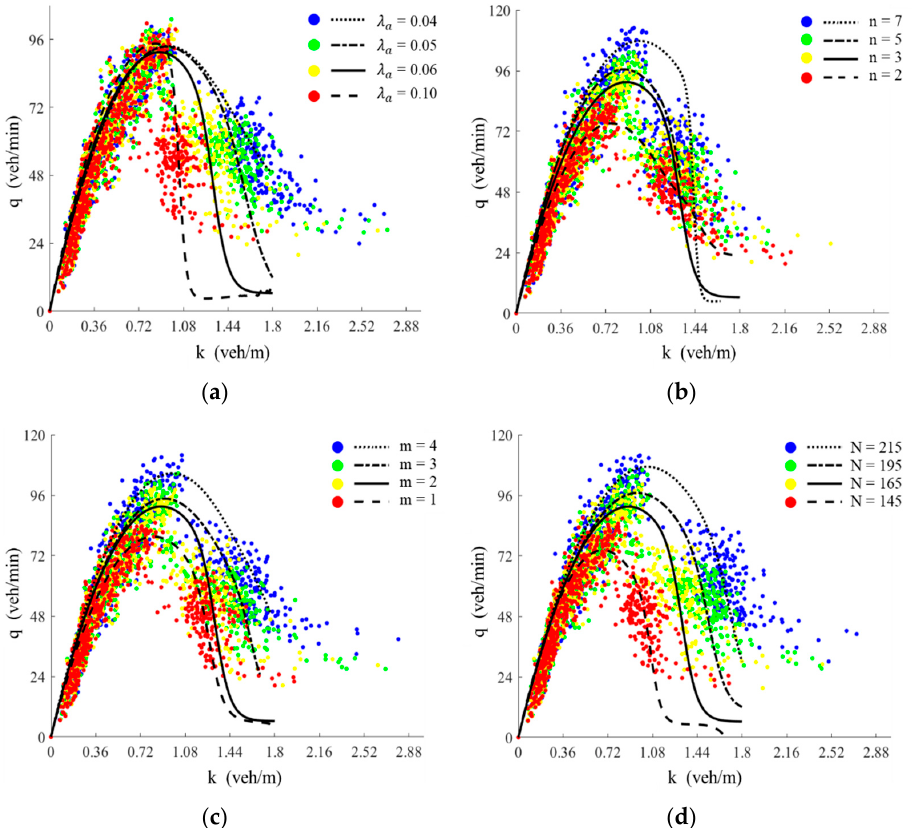
Figure 5. Fitted curves for different design parameters. ( a ) is the result at different values of λ a ; ( b ) is the result at different values of n ; ( c ) is the result at different values of m ; ( d ) is the result at different values of N